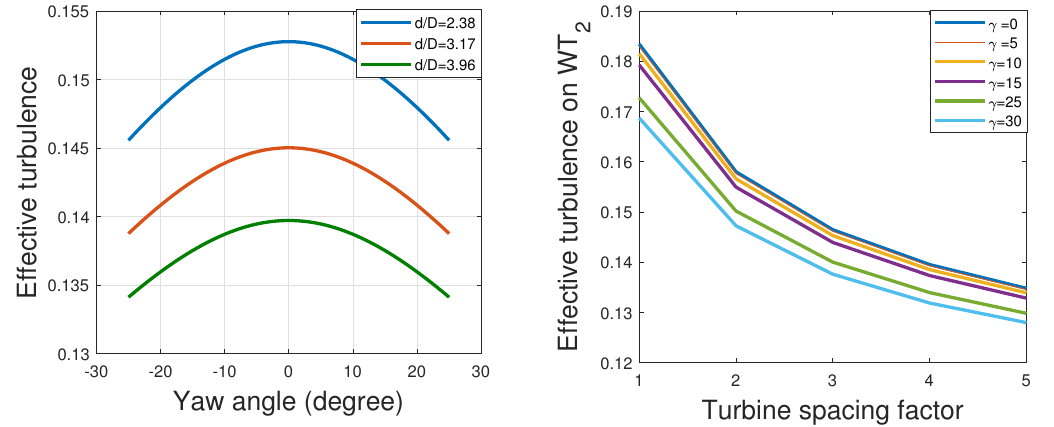
Figure 11. Variation of effective turbulence with yaw angle misalignment.